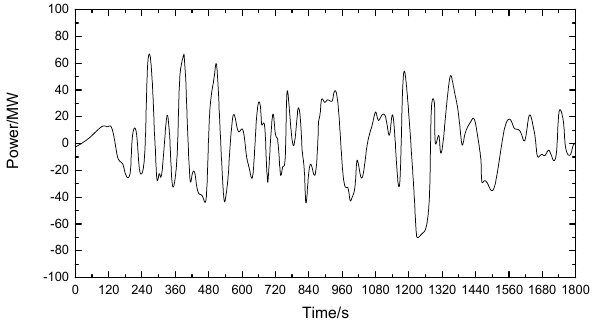
Figure 5. Target stabilization of distributed hybrid energy storage system.